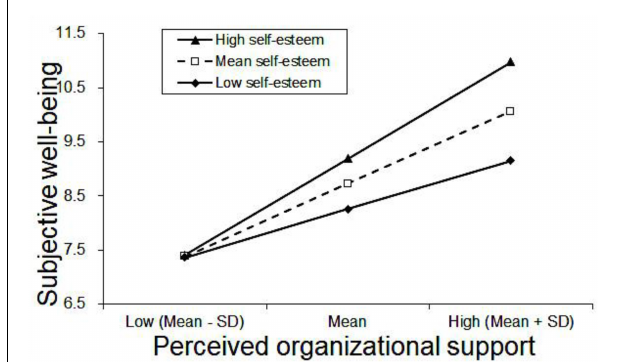
FIGURE 1 | Simple slope plot of the interaction between POS and self-esteem on SWB. The values of POS and self-esteem were centered before regression analysis. Low indicates 1 SD below the mean; high indicates 1 SD above the mean; SD indicates standard